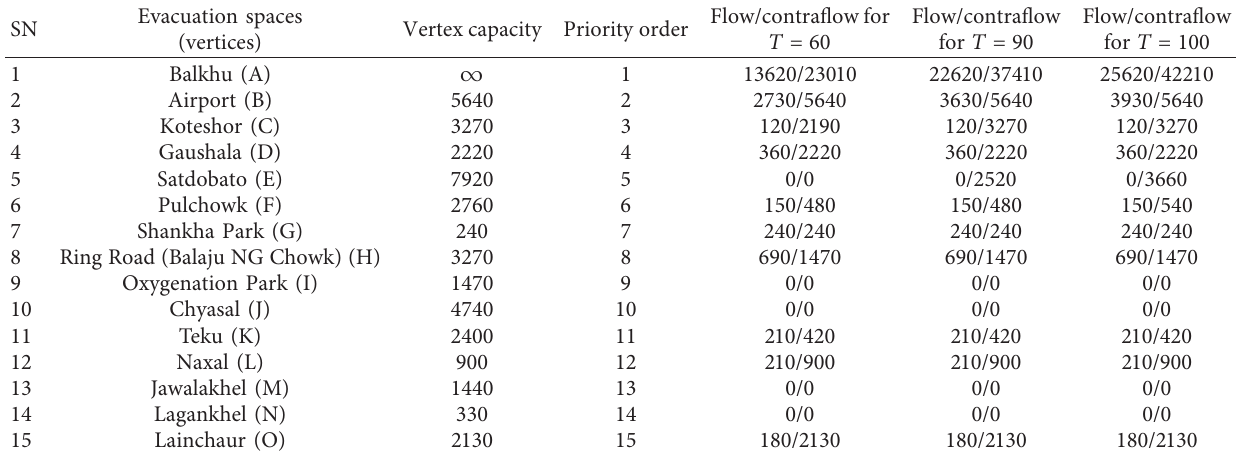
Table 2: Maximum flow values (evacuees) at sink (Balkhu) and intermediate vertices for Scenario II. Evacuation spaces SN